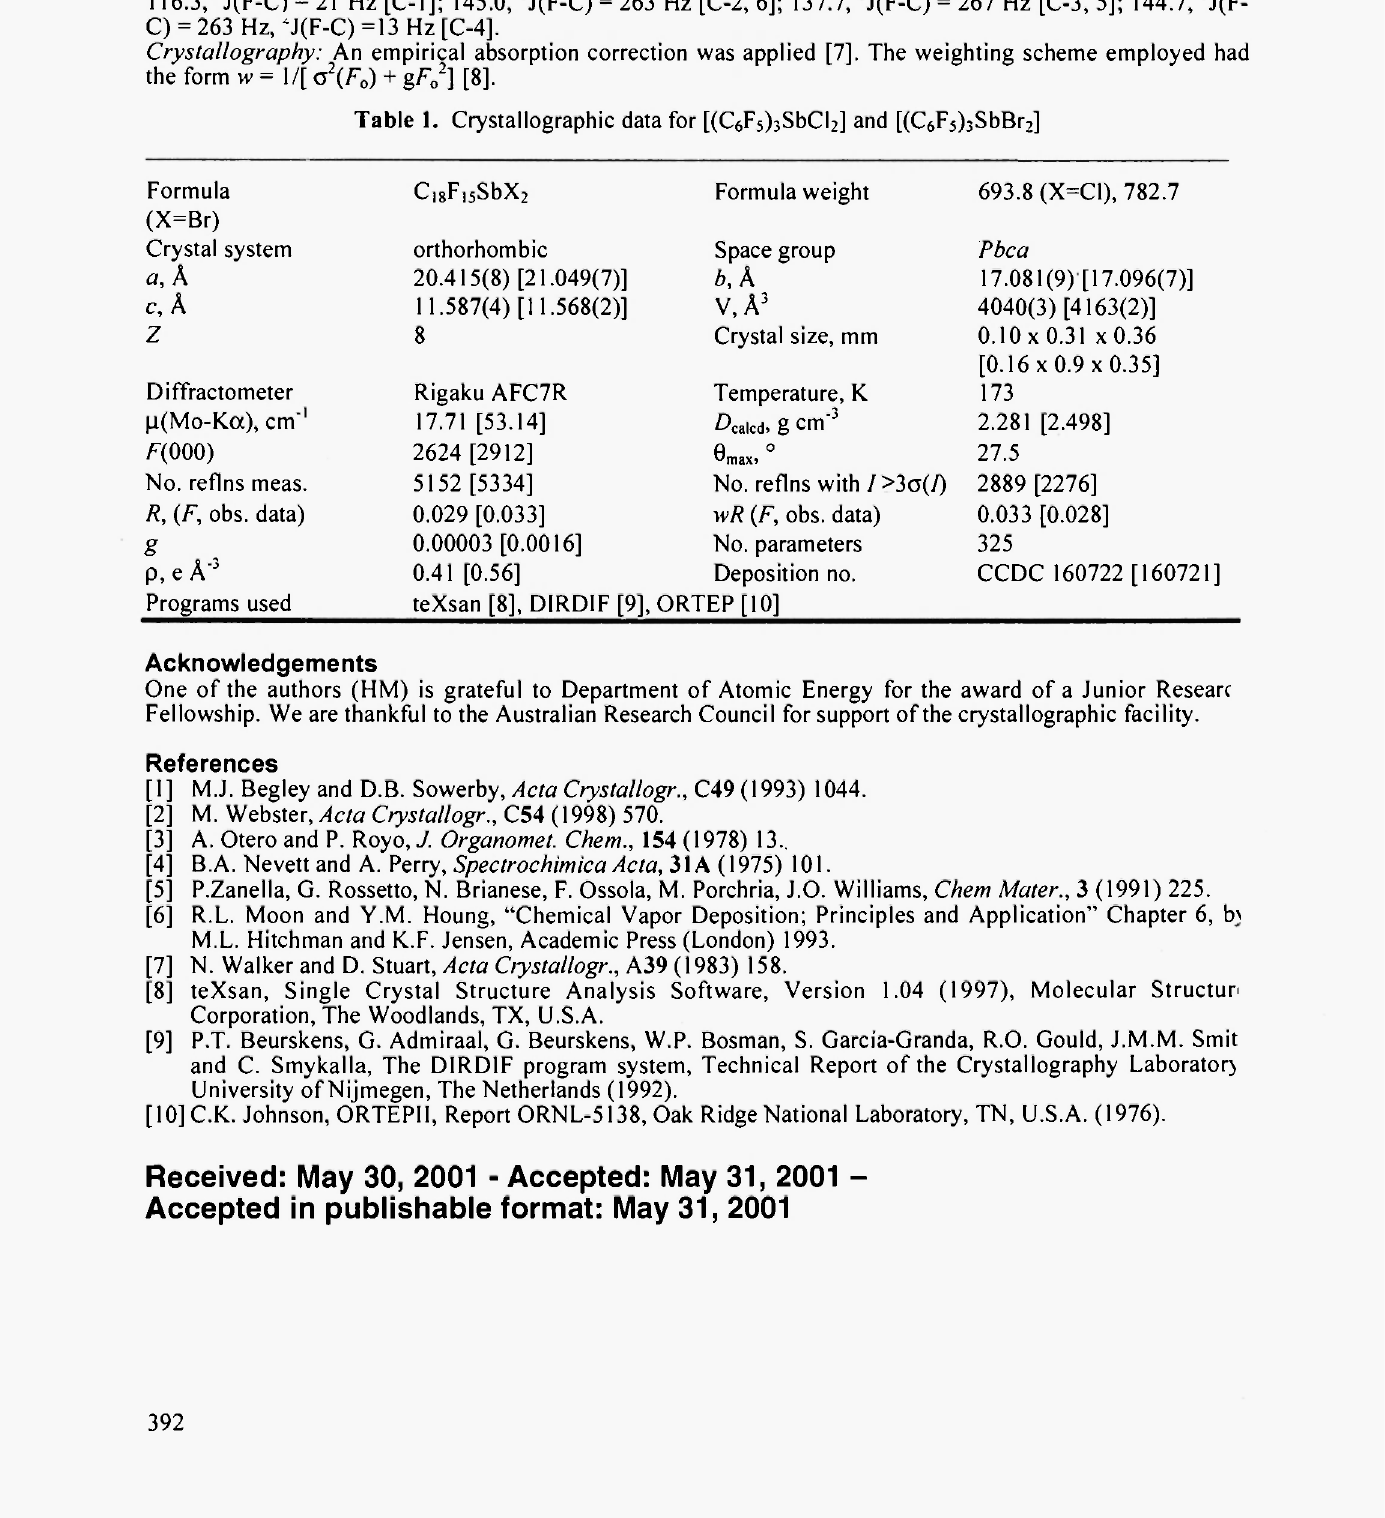
Table 1. Crystallographic data for [(C 6 F 5 ) 3 SbCl2] and